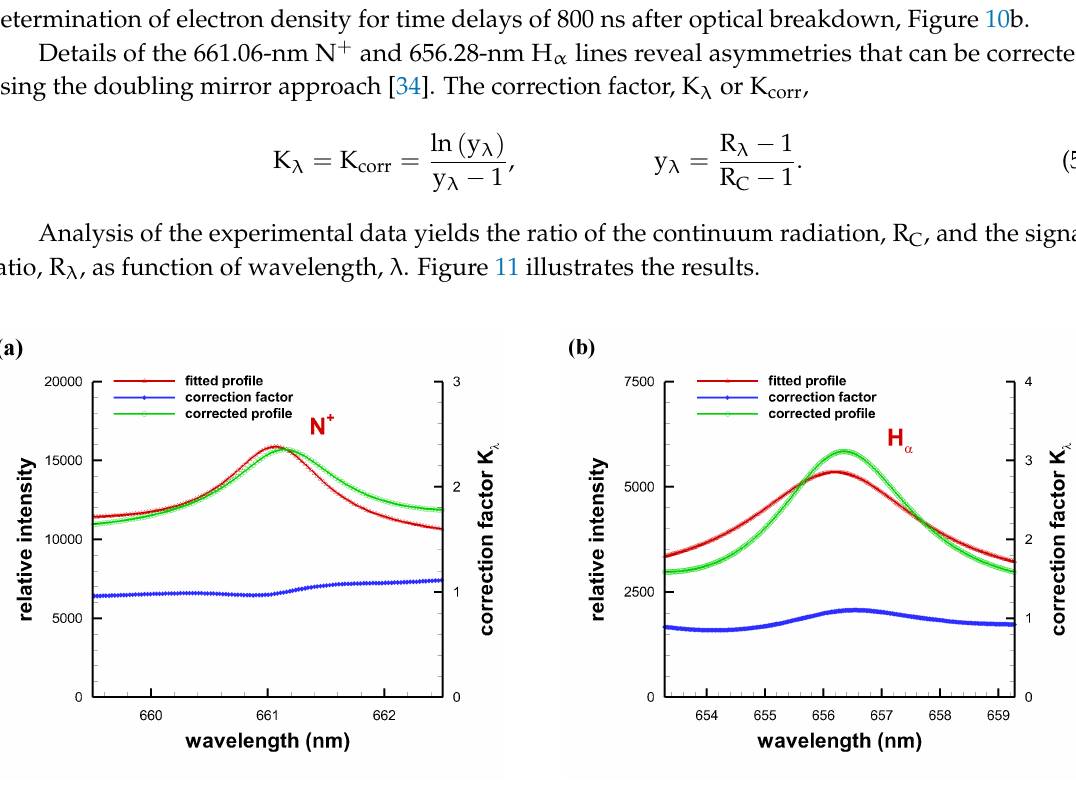
Figure 11. Corrected and fitted profile with correction factor. The fitted profile is obtained by determining the Lorentz profile from the experimental data: ( a ) N + for a time delay of 300 ns; and ( b ) H α for a time delay of 800 ns. Slit height: 6.15 mm. Reproduced from Ref. [31] with